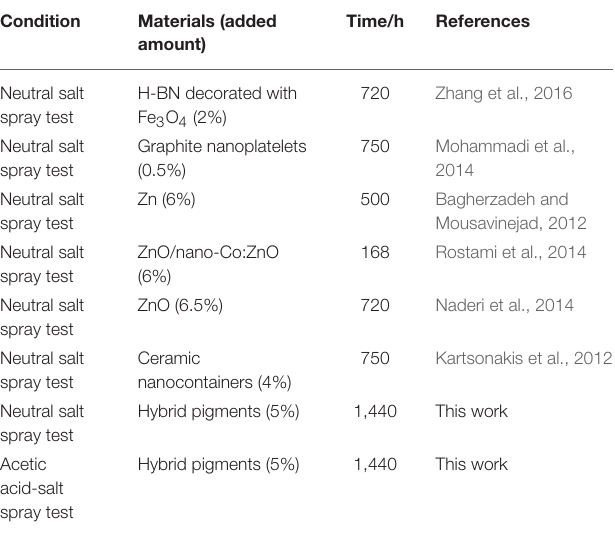
corrosion current decreases from − 3.39 × 10 − 8 A to − 5.75 × 10 − 12 A, while the corrosion potential increases from − 1.439 V to − 0.443 V. In fact, the anticorrosion ability of the coating is related to the chemical composition and microstructure. The suggests the better of the anticorrosion ability (Liang et al.,